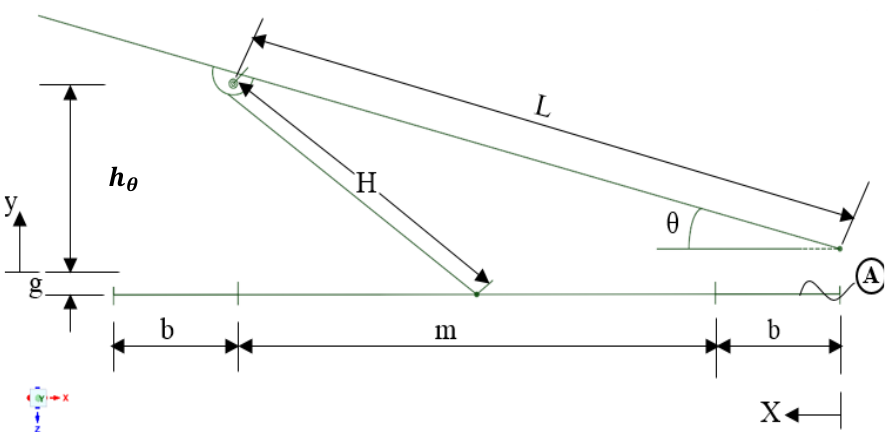
Figure 7. The notation analysis for the